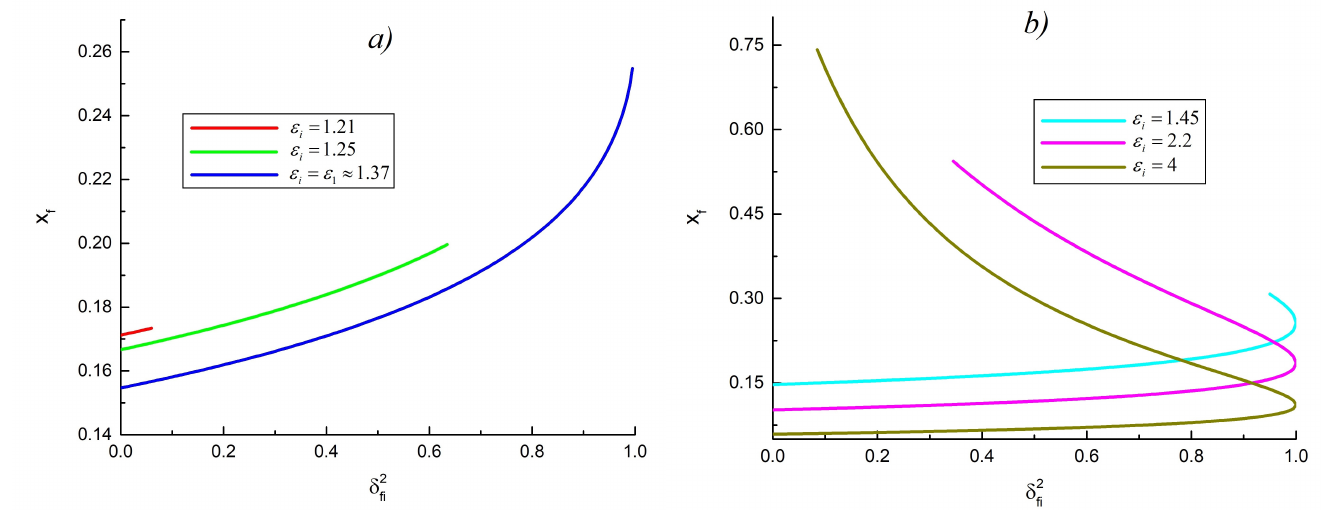
Figure 4. ( a ) The energy of the scattered electron (see Expression (17)) for different values of the energy of the initial electron from the closed interval ε i ∈ [ ε thr ≈ 1.21, ε 1 ≈ 1.37 ] . ( b ) The energy of the scattered electron (see Expression (17)) for different values of the energy of the initial electron ε i > ε 1 ≈